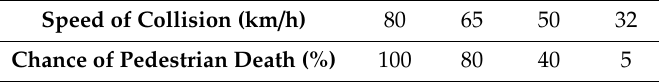
Table 1. Chance of pedestrian death if hit by a motor